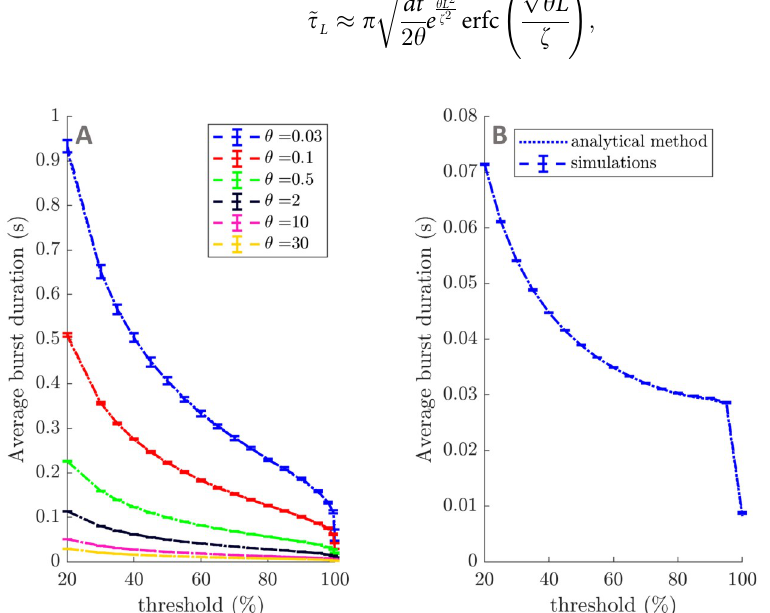
Fig 10. Simulations of average burst duration profiles for OU processes and a third degreepolynomial model. Average burst duration profiles from simulations of OU processes are compared to Eq (11) for a range of decay parameters and z = 1 in panel A. Similarly, average burst duration profiles from simulations of a third degree polynomial envelope model are compared to Eq (48) in panel B. Simulations are indicated by dashed lines (SEM error bars), and analytical results by dotted lines. Simulations consist of five repeats of 10 5 s, with a time step of 1 ms (OU process simulations use the exact updating Eq